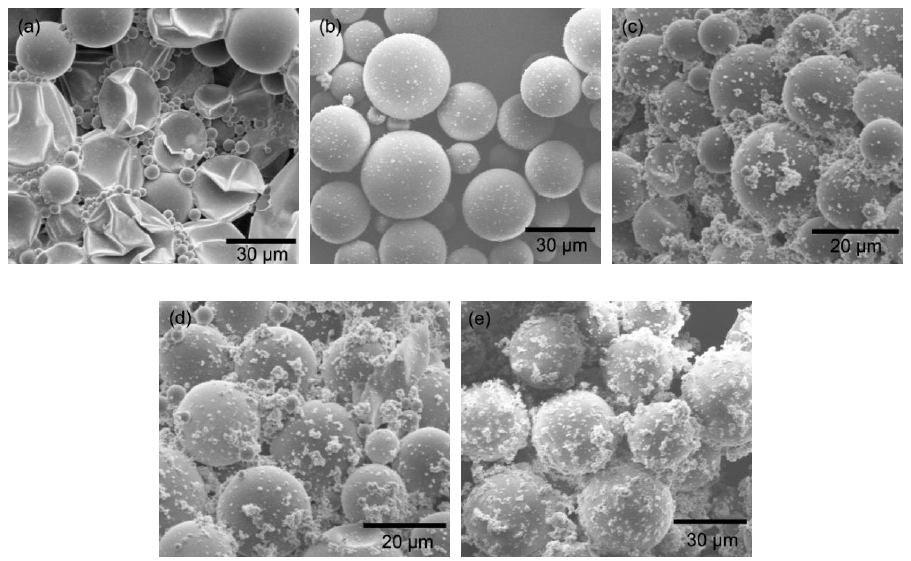
Figure 4. SEM images of microcapsules ( n -hexadecane as core materials) prepared under different polymerization times: ( a ) 1 h, ( b ) 2 h, ( c ) 3 h, ( d ) 4 h, and ( e ) 5 h. The emulsification speed and surfactant volume were kept at 3000 rpm and 28 mL, respectively.